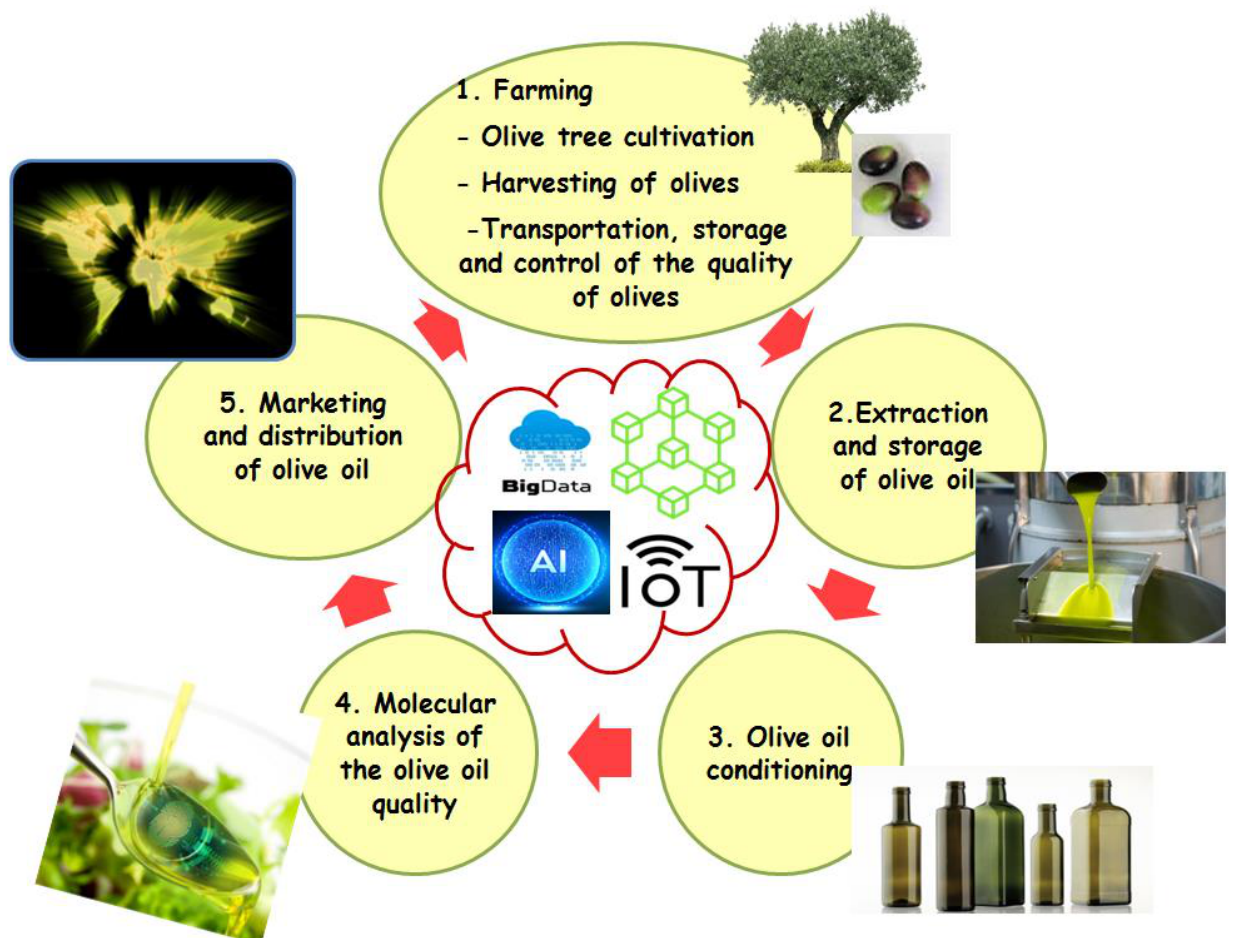
Figure 2. Integration of technology 4.0 in the olive oil supply chain.